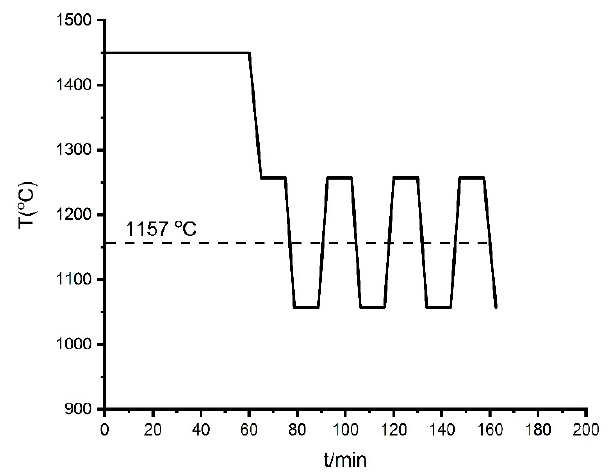
Figure 6. A graphic representation of the typical thermal cycle experiment.